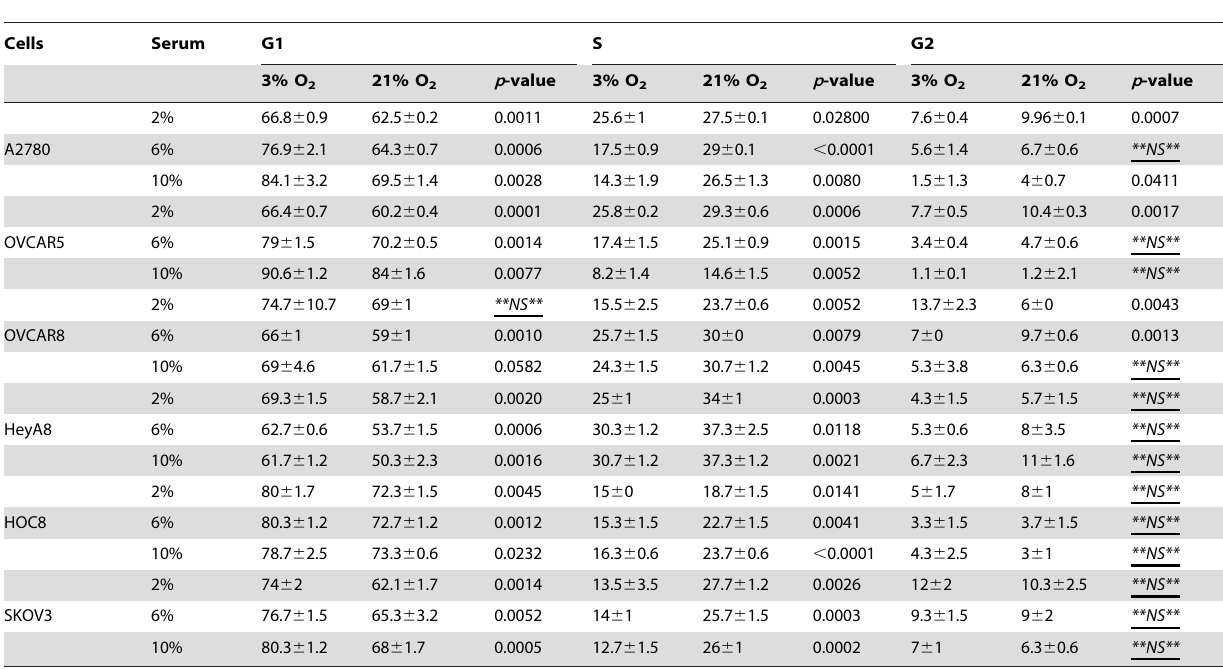
Table 1. FACS profile for cell cycle analysis with ovarian cancer cells that were grown under cell culture conditions consisting of increasing serum and O 2